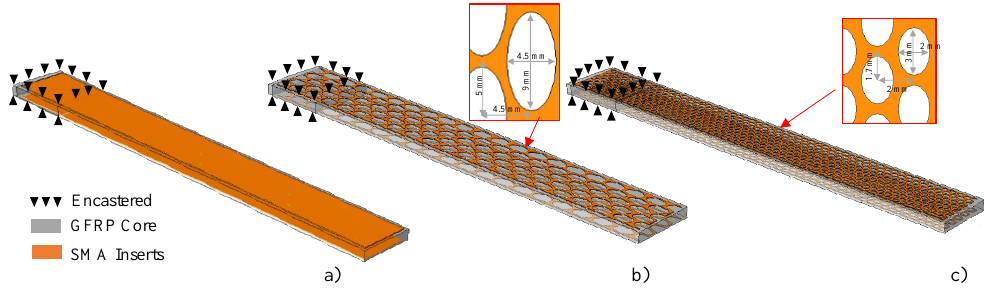
Figure 8. Schematic of a cantilever beam with different hybrid layups. ( a ) Plain; ( b ) Large pattern; ( c ) Small